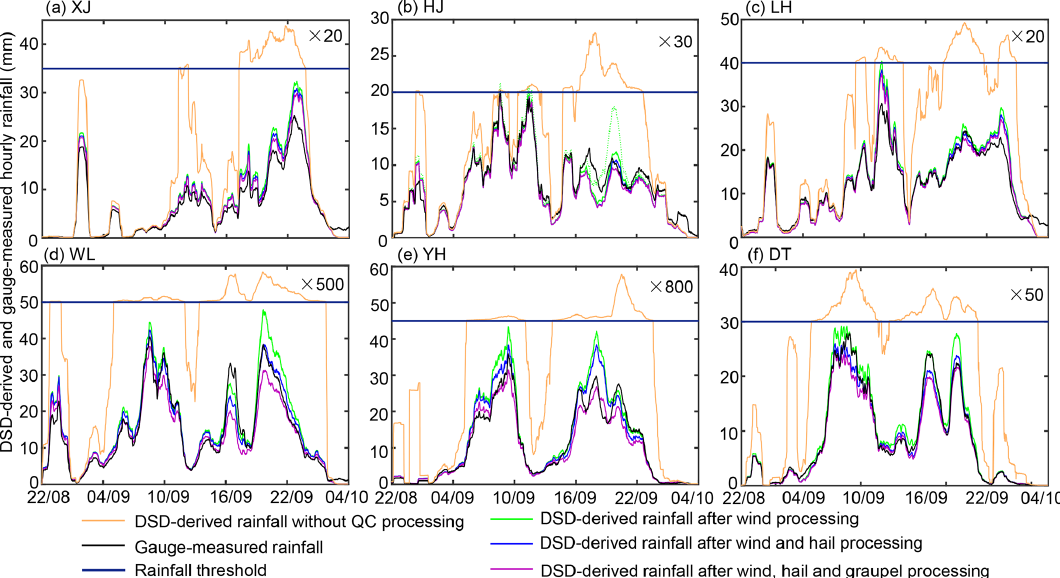
Figure 6. Time series of DSD-derived and gauge hourly rainfall. Panels (a) – (f) are obtained from XJ, HJ, LH, WL, YH, and DT, respectively, during 22:00UTC, 8 August 2019, and 04:00UTC, 10 August 2019. The number following × refers to C T , and bold, dark blue straight lines indicate the threshold of R T of each station according to Eq. (5). The green dotted line in (b) is conditioned by V M ∈ [0.4 V B , 1.5 V B ], and other green solid lines are conditioned by V M ∈ [0.5 V B , 1.5 V B ].